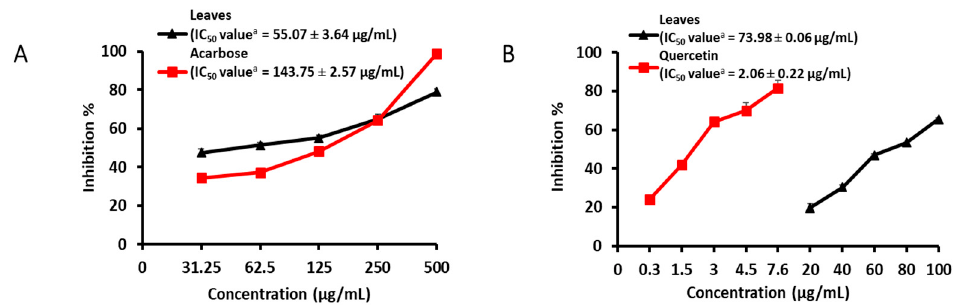
Figure 2. Concentration-dependent ( A ) α -glucosidase and ( B ) BACE1 inhibitory activity of MeOH extract of leaves of C. maackii along with the standards, acarbose and quercetin, respectively. Error bars indicate standard deviation (SD).